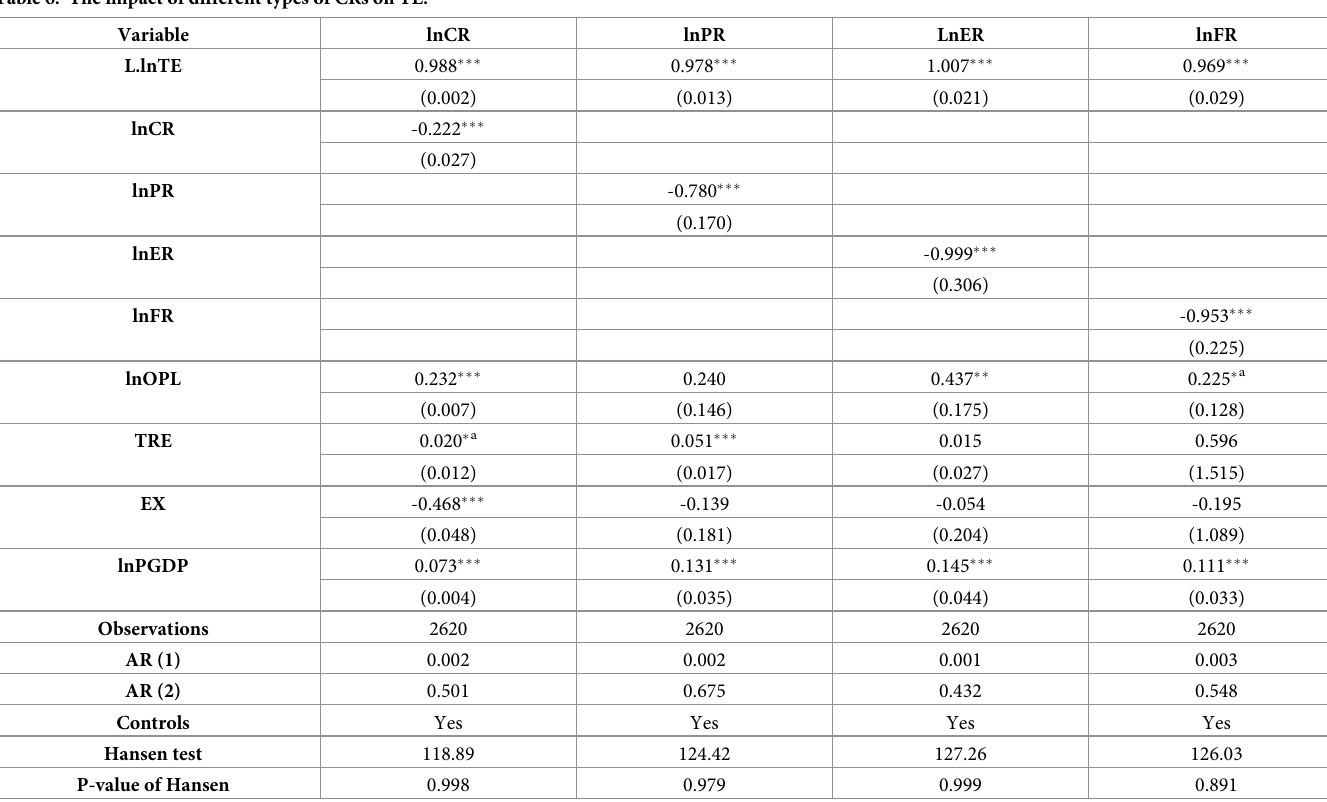
Table 6. The impact of different types of CRs on